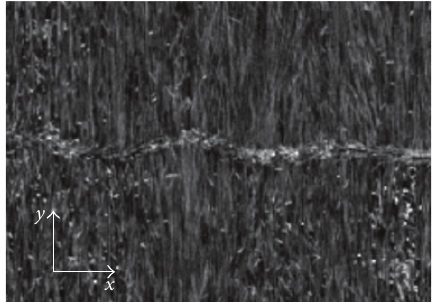
Figure 30: CT picture of the weld of PP-GF30 with initial fiber orientation being longitudinal to the joining direction (DP